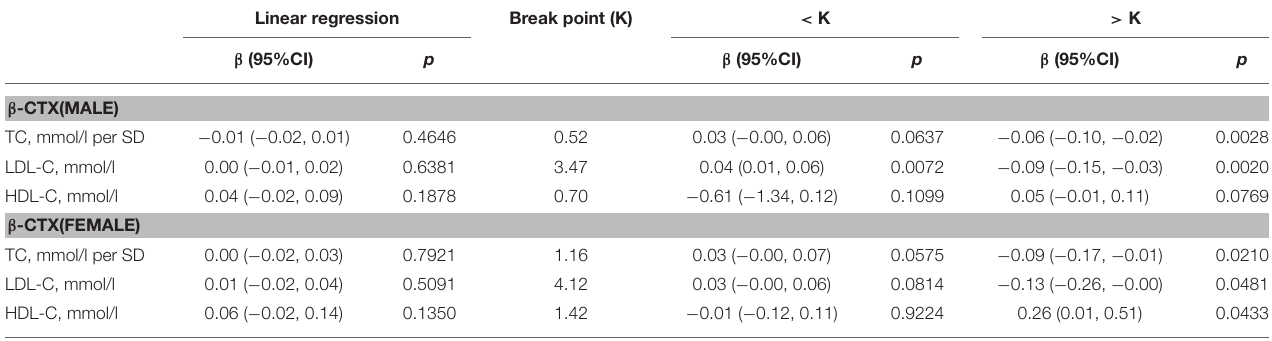
TABLE 8 | Multivariate Regression for Effect of TC, HDL-C, and LDL-C on PTH. Linear regression Break point (K) < K > K β (95%CI) p β (95%CI) p